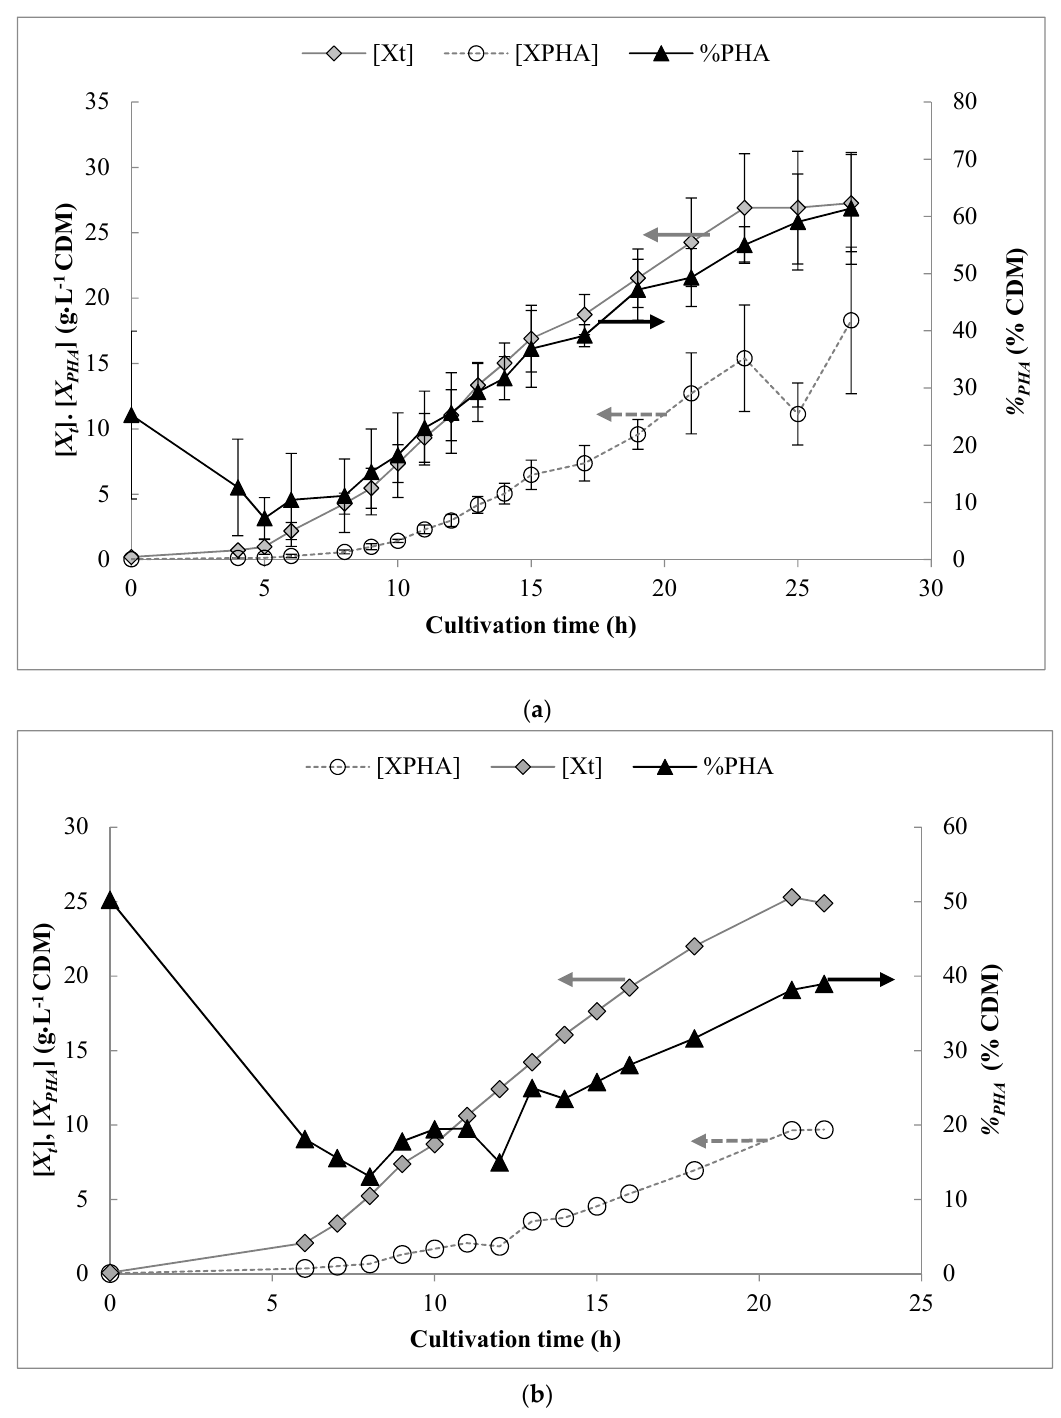
Figure 1. Results for biomass and PHA production obtained over the course of the pulse-feed fed-batch experiments ( a ) bench-scale bioreactor system (3 L initial working volume) and ( b ) pilot-scale bioreactor system (70 L initial working volume).